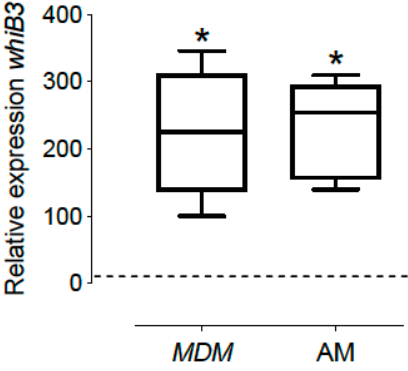
Figure 1. whib3 expression of M. tuberculosis in intracellular bacteria in MDM and AM compared to aerobic in vitro 7H9 growth during mid-exponential growth phase (control, dashed line). Total RNA was isolated and real-time qRT-PCR was performed. Relative expression levels of whiB3 were estimated using the RNA 16S transcript as internal control for normalization of RNA amounts; expression levels from an in vitro culture were used as control. MDM: Monocyte-derived macrophages and AM: alveolar macrophages. The data show the maximums and minimums by quartiles. * p < 0.05 significant difference compared to the expression of control (bacteria cultivated in vitro), n = 6. The dashed horizontal line represents the median, and the Wilcoxon test was used to compare against the control.